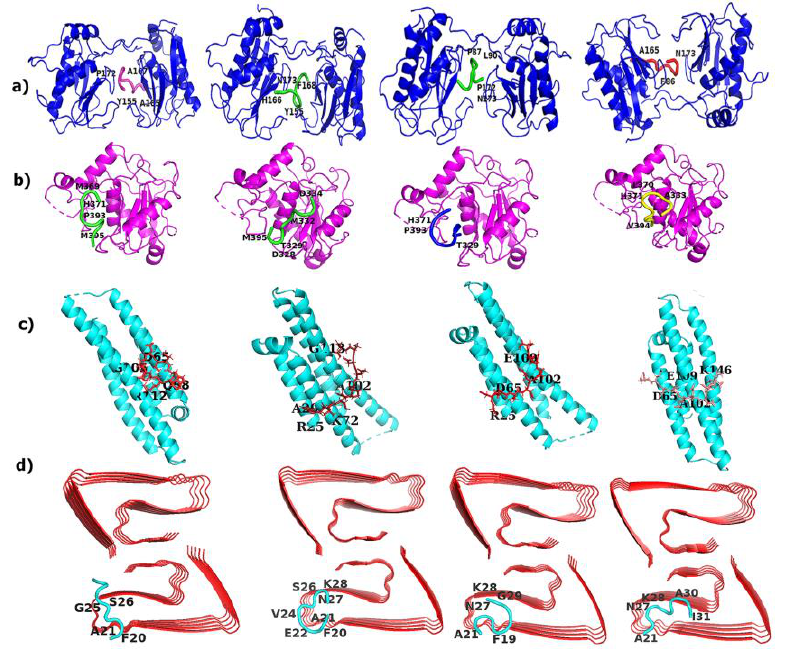
Figure 5. Left to right shows docked images of TauRP (1 – 2), TauRP (1 – 4), TauRP (1 – 8) and TauRP (1 – 14) with ( a ) MMP-13, ( b ) ADAMTS-4, ( c ) receptor-binding domain of ApoE4, ( d ) Aβ (1– 42) fibrils.